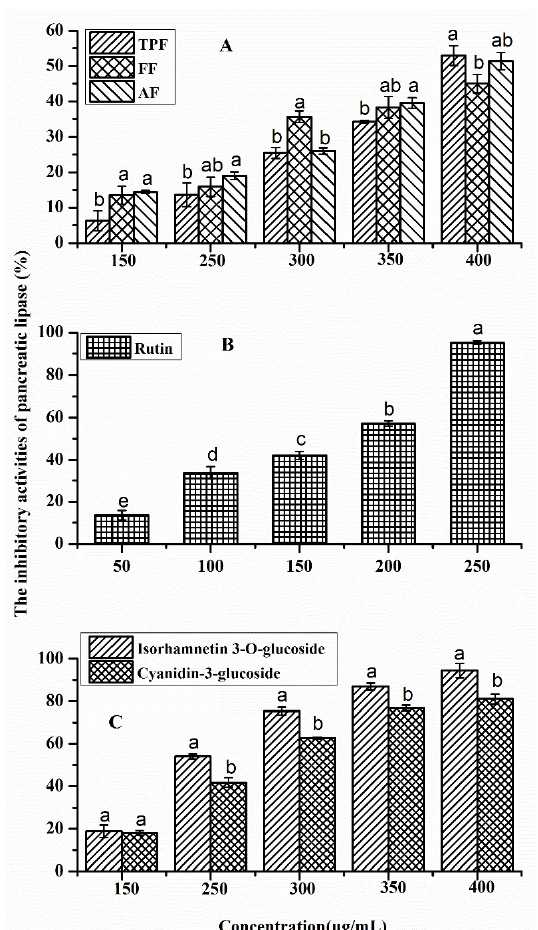
Figure 4. Inhibitory ratio of porcine pancreatic lipase activity by different fractions from P. utilis fruits ( A ), rutin ( B ), and isorhamnetin-3- O -rutinoside and cyanidin-3- O -glucoside ( C ). Values are showed as the mean ± SD ( n = 3). The means in Figure 3A,C with different letters at the same concentration